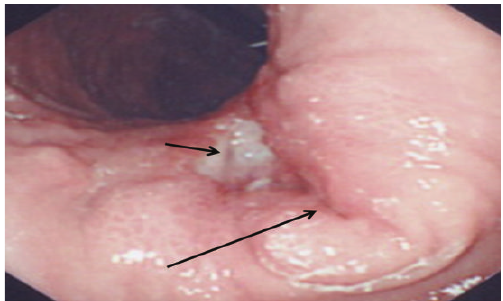
Figure 2: Barium meal shows obstruction at pylorus (white arrow) and a crater of an ulcer (black arrow).